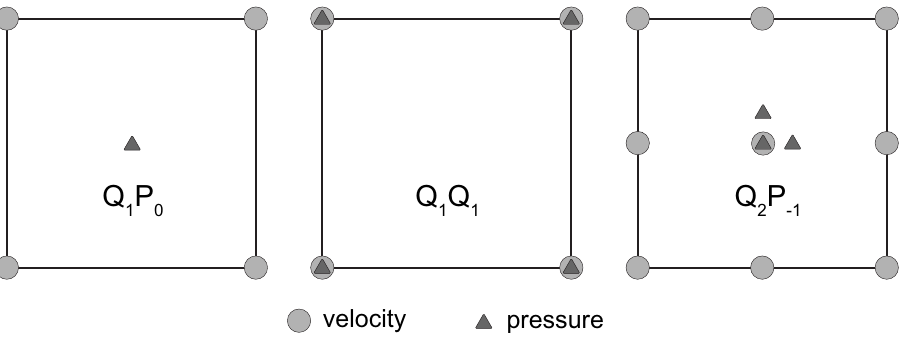
Figure 1. Mixed velocity-pressure